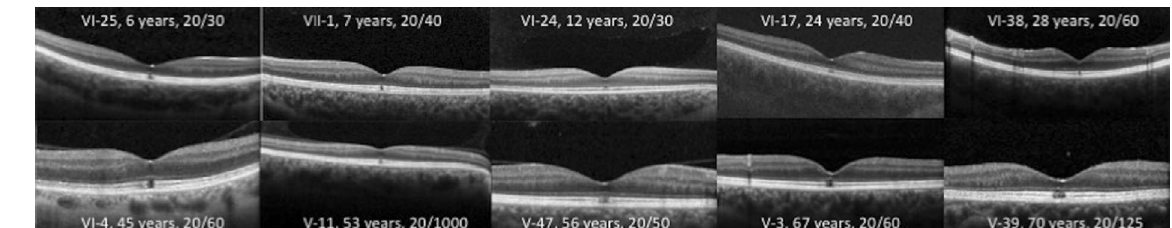
Figure 3. Unique foveopathy associated with SSBP1 -related DOA. The SSBP1 -related foveopathy is characterized by a tiny disruption of ellipsoid and interdigitation lines. Regardless of the age of the patient, the foveopathy always had the same appearance in ten different affected patients ranging in age from 6 to 70 years. Photographs were taken by